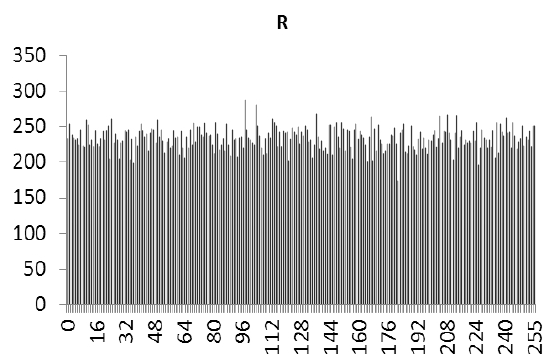
Figure 20. Statistical chart of R value distribution after